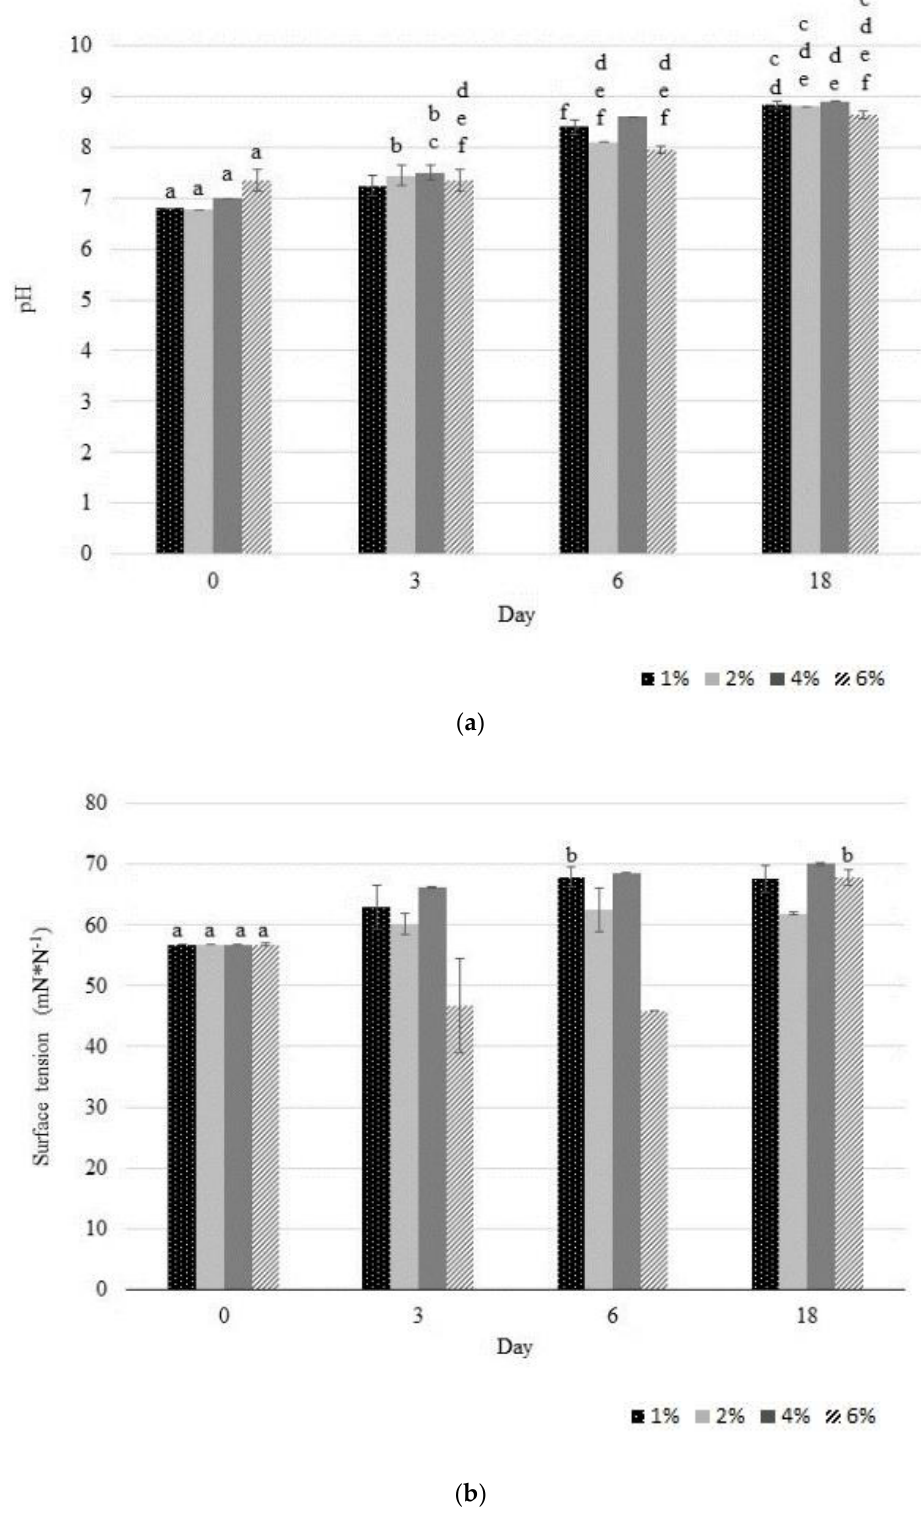
Figure 4. Variation in pH ( a ) and in surface tension ( b ) leachate observed during the accumulation study of Mn by the 2De strain using di ff erent soil concentration from the metallurgical waste. The same letter indicates no significant di ff erences among groups (LSD, p < 0.05). Error bars are standard deviation ( n = 3).